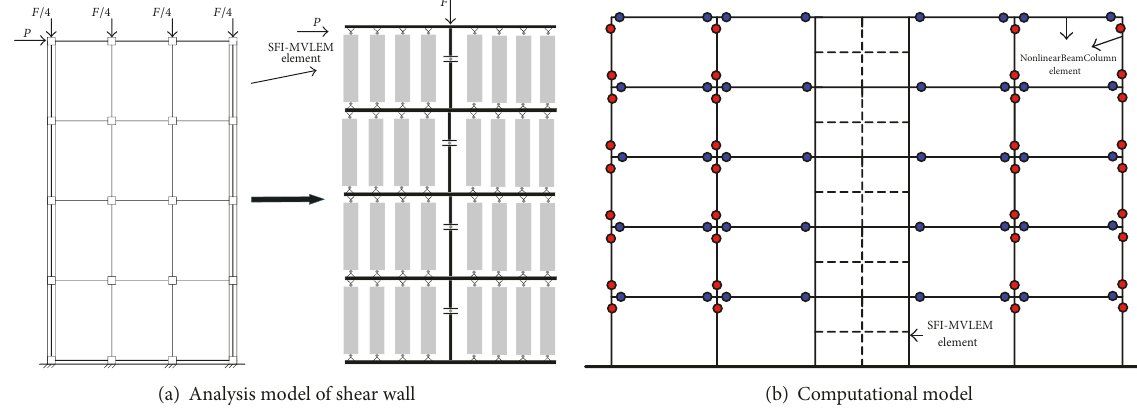
Figure 4: Finite element